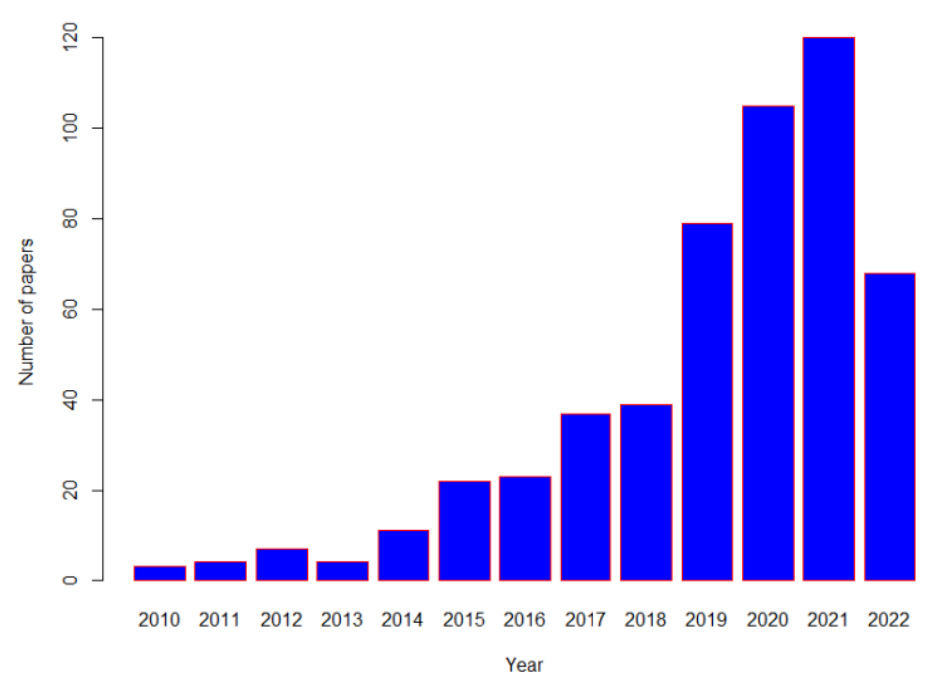
Figure 1. Number of published Mendelian Randomization studies related to nutrition in Pubmed from 2010 up to 10 June 2022.